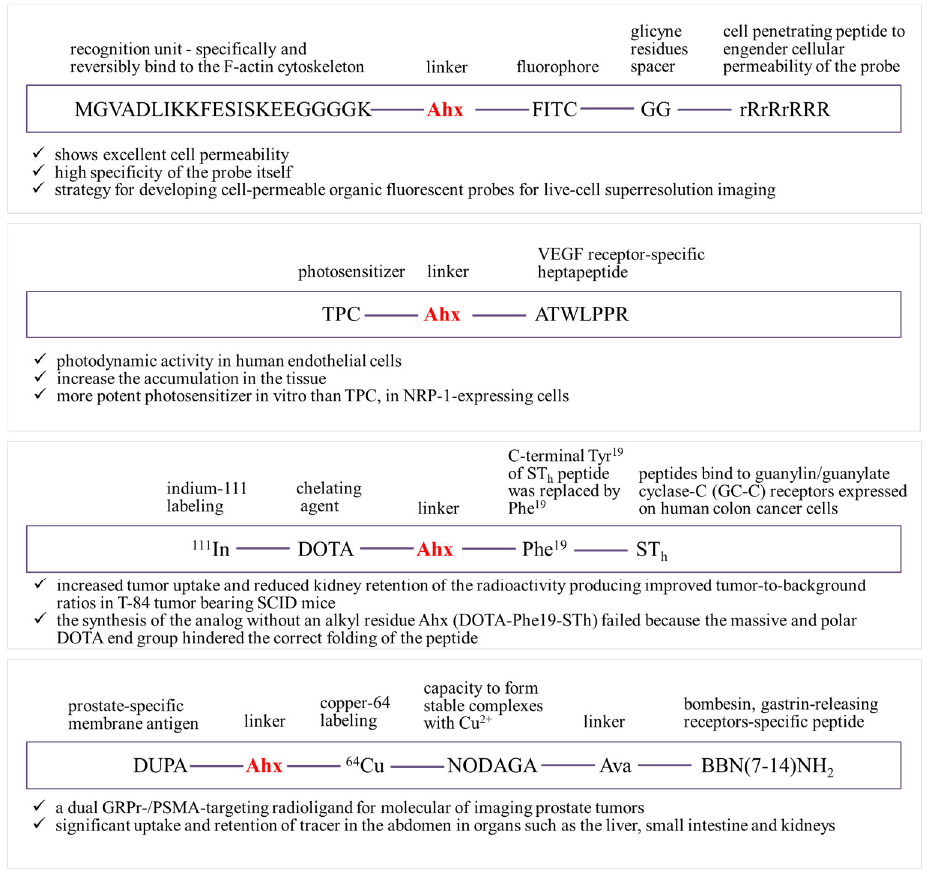
Figure 4. Examples of structures using Ahx as linker in receptor affinity peptide structures.